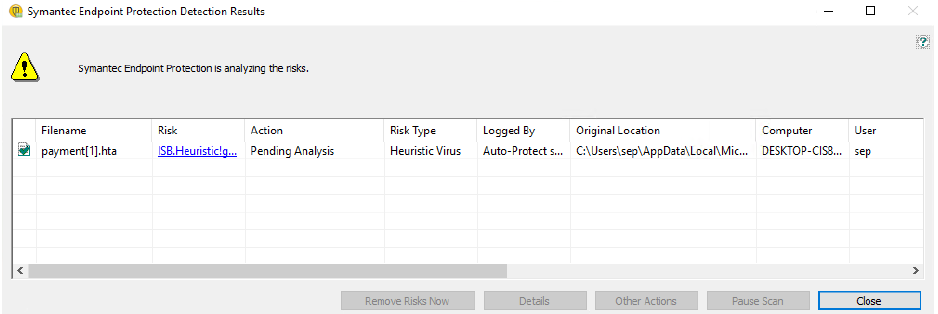
Figure 23. Identified and blocked HTA attack from Symantec Endpoint